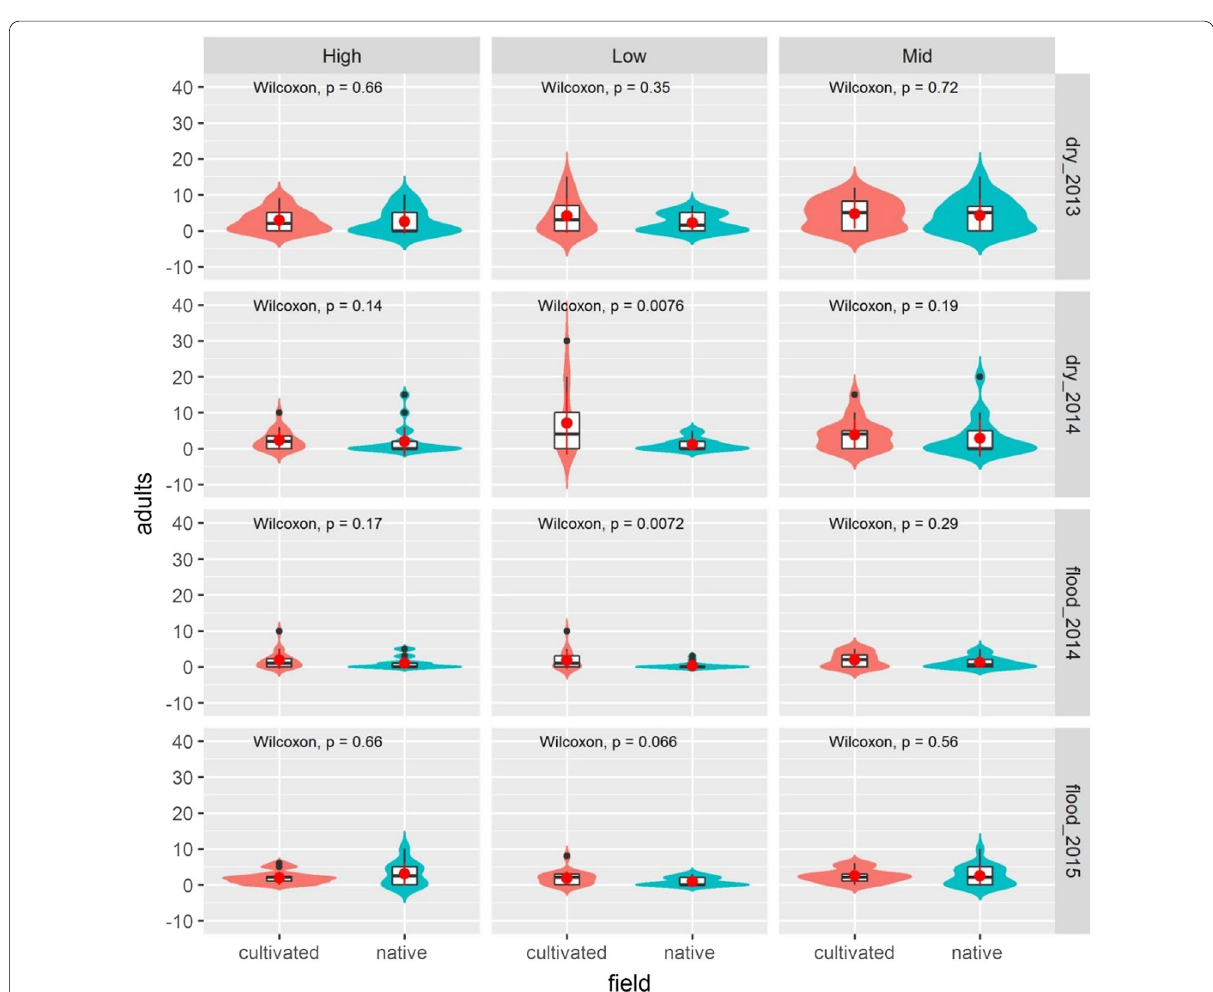
Fig. 2 Differences in number of adult individuals between type of grasslands (native and cultivated), by seasonal flood disturbance (post-flood and post-dry disturbance) and topographical conditions (low, mid, high), Pantanal wetland. We classified the topographical gradient into three levels: (1) low–longer duration of flood; (2) mid–intermediate level; and (3) high–short duration of